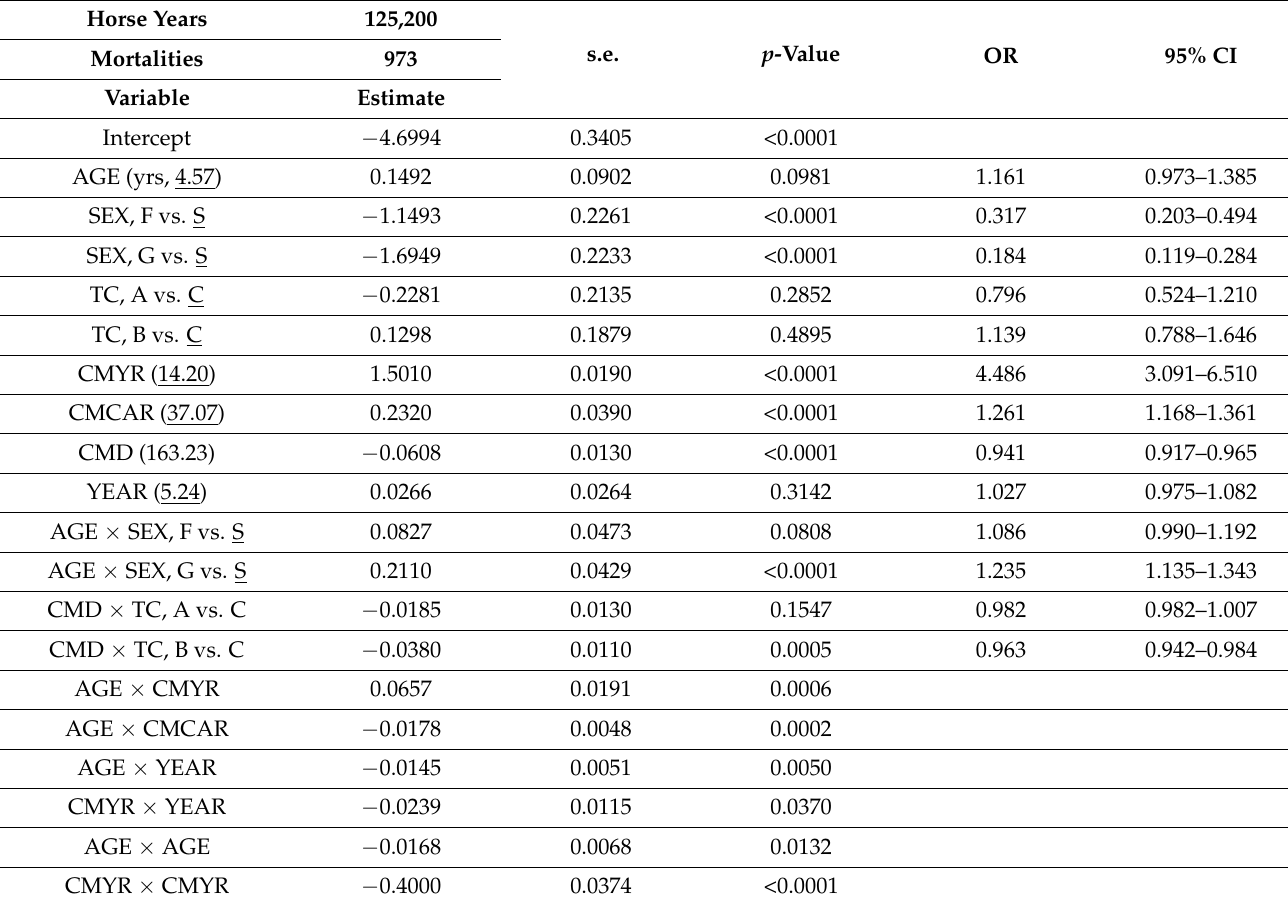
Table 5. Results of Logistic Regression Modelling of Associations with Membership in the Ontario Racing Death Registry (binary response) for Standardbred Horses for the period 2003–2015, Unit of interest—Horse-Year. Horse